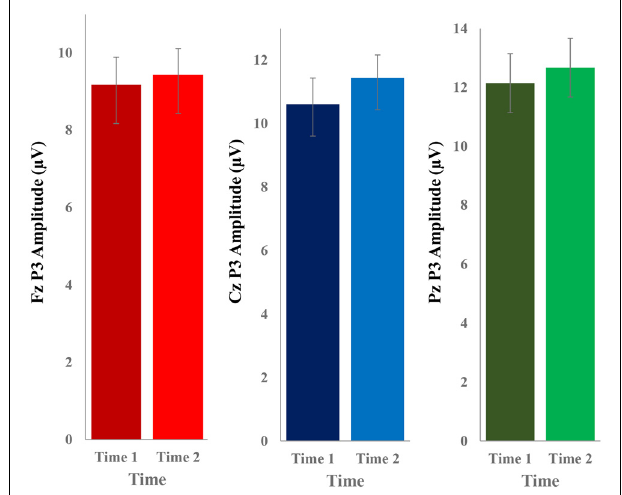
FIGURE 5 | Bar graph of the mean ( ± SEM) P3 amplitude (in µ V) in response to novel stimuli at Fz, Cz, and Pz at Time-1 and Time-2.